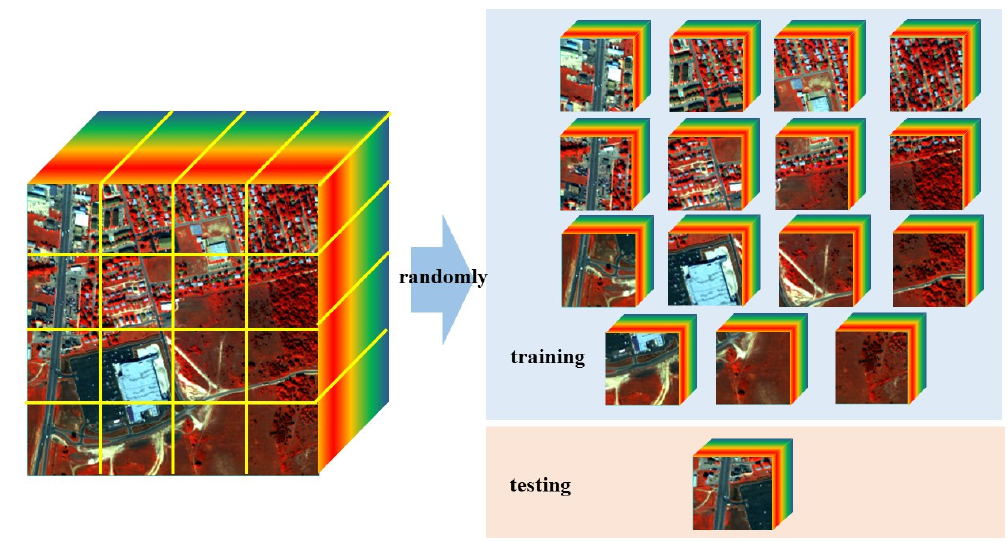
Figure 4. The Map of the Composition Structure of Training and Testing Figure 4. the Map of the Composition Structure of Training and Testing Data.